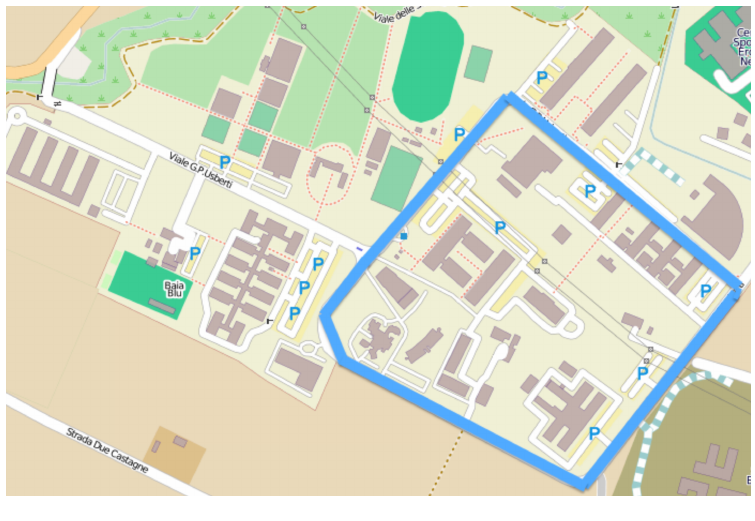
Figure 21. Circuit followed by the vehicles during the tests. Image taken from Open Street Map.